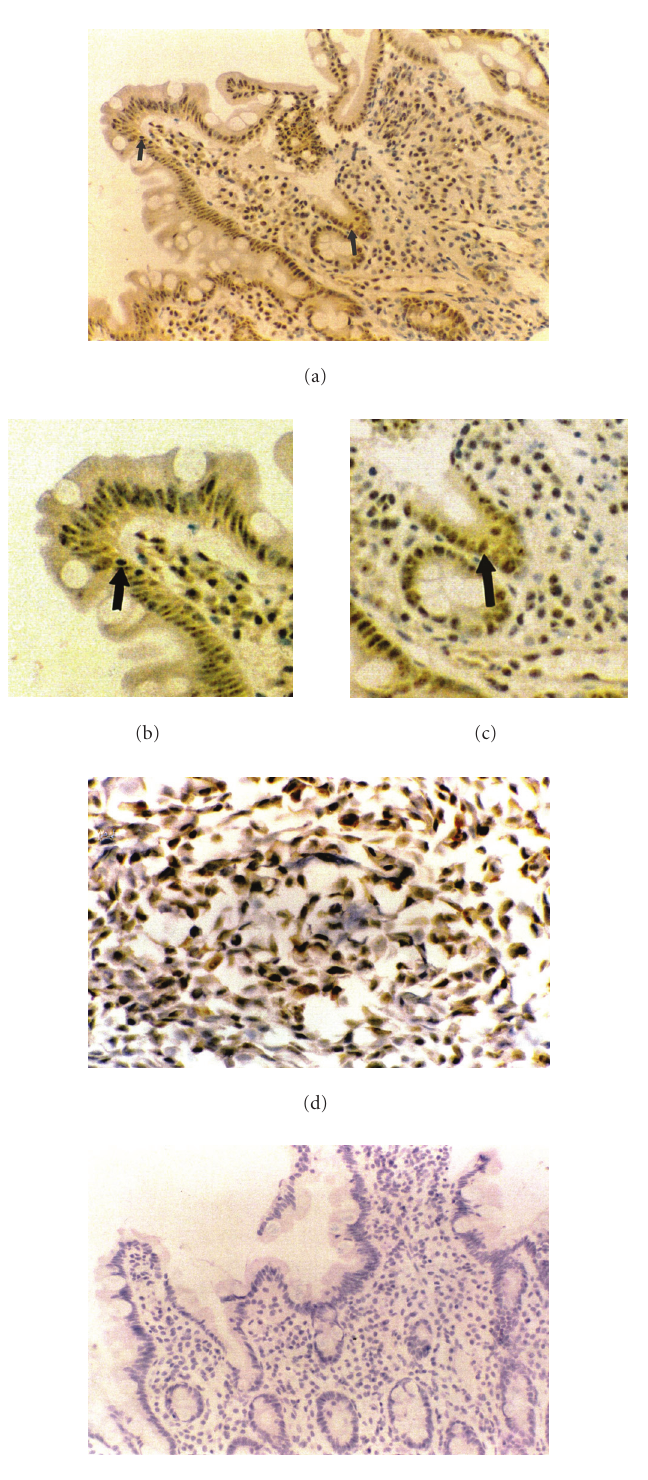
Figure 4. Immunohistochemistry of LAR staining on duodenal biopsy tissue. (a) Duodenal biopsy tissue stained with anti-LAR at magnification of × 200. The positive staining is brown and the presence of IEL with weak staining is indicated by black arrows. (b) Note: LAR expression in intraepithelial lymphocytes at the tips of the villi is very low (indicated by a black arrow). (c) Staining is stronger in the IEL within the lower third of the crypt (indicated by a black arrow). (d) Staining of positive control HUVECs with anti-LAR antibody. (e) Staining of duodenal biopsy tissue with anti-KLH, negative